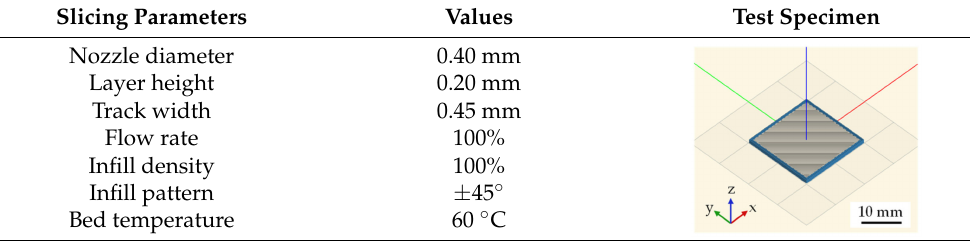
Table 2. Used printing parameters set in Slic3r and corresponding representation of test specimen. Slicing